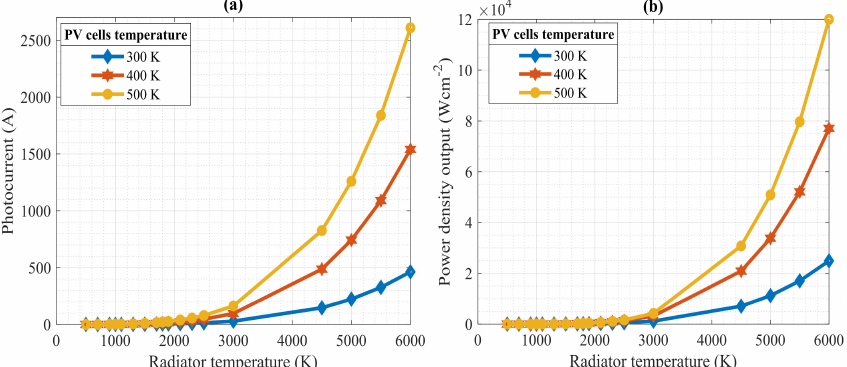
Figure 4. Relationship between ( a ) radiator temperature and photocurrent, ( b ) radiator temperature and power density output at a constant PV cells temperature at 300